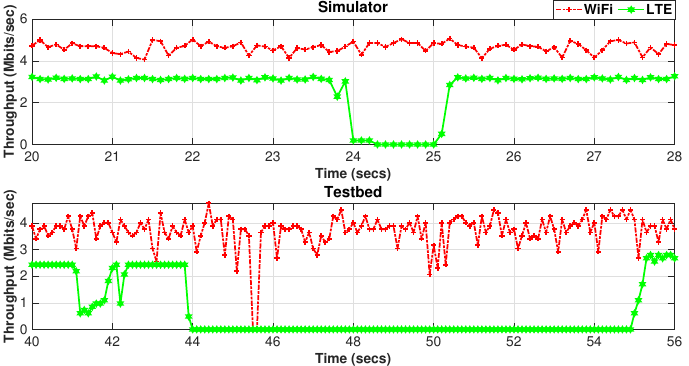
Figure 17. Setup 1 Wi-Fi/LTE subflow throughput variation with time for wVegas during handover occurrence.